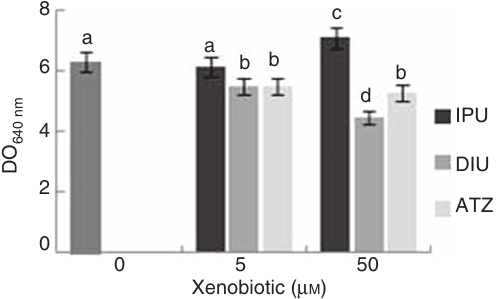
Figure 3: Optical density in the presence or absence of IPU, DIU and ATZ in Saccharomyces cerevisiae UE-ME